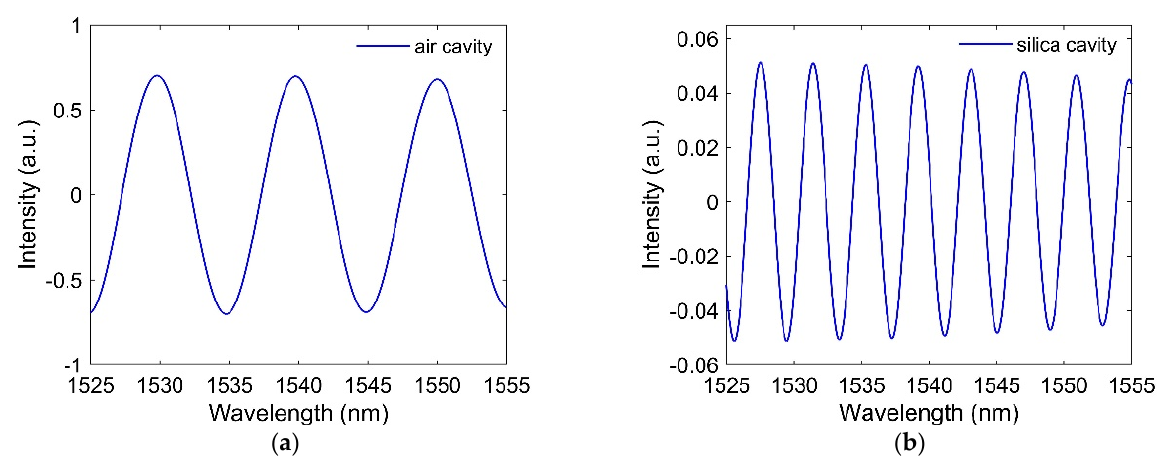
Figure 3. Retrieved signals using bandpass filters and inverse FFT for ( a ) air cavity and ( b ) silica cavity. Table 1. Original and retrieved lengths of cavities of the cascaded FPI .